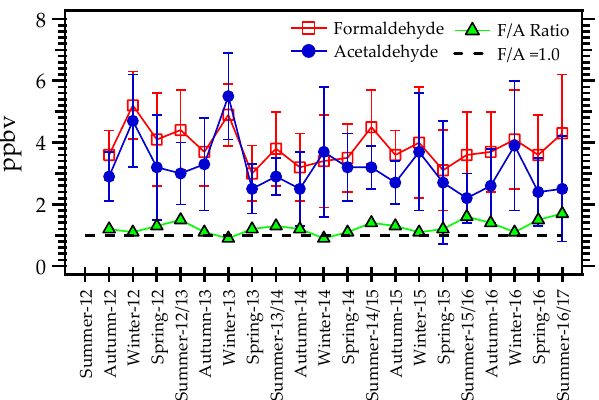
Figure 2. Seasonal variations in formaldehyde and acetaldehyde concentrations at the Pinheiros air quality monitoring station [24] between 2012 and 2016. The black line represents a formaldehyde/acetaldehyde (F/A) ratio of 1.0, and the green triangles represent the observed F/A ratios.